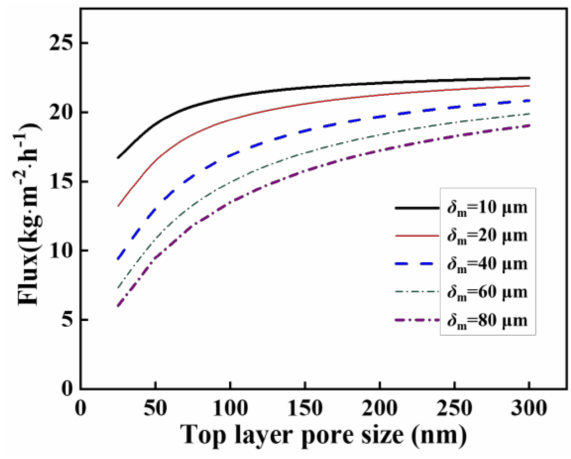
Figure 3. Effect of pore size and thickness of the top layer on water flux.